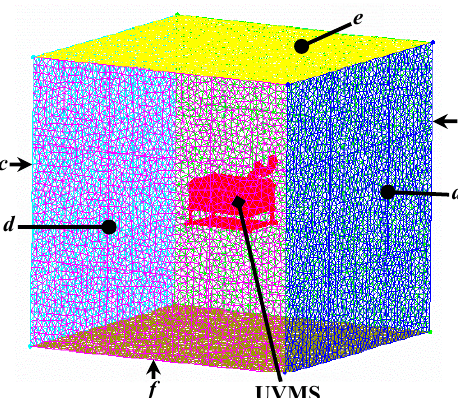
Figure 2. Flow Field Domain of the UVMS.